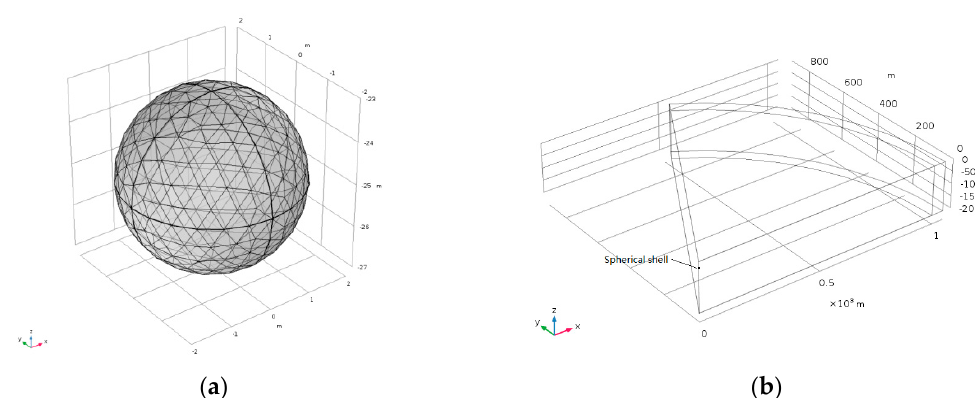
Figure 5. The schematic diagram of the COMSOL model. ( a ) The schematic diagram of the spherical shell in COMSOL; ( b ) The schematic diagram of the sea channel in COMSOL.